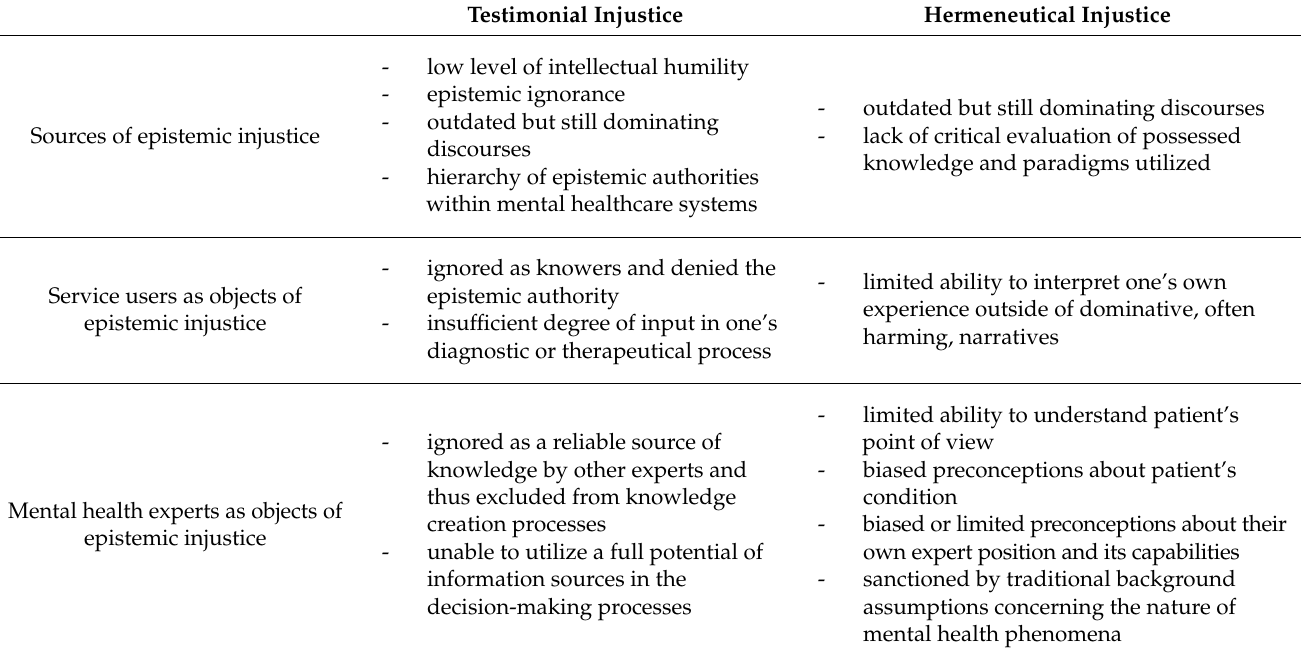
Table 1. Epistemic injustice as affecting both service users and mental health experts. Testimonial